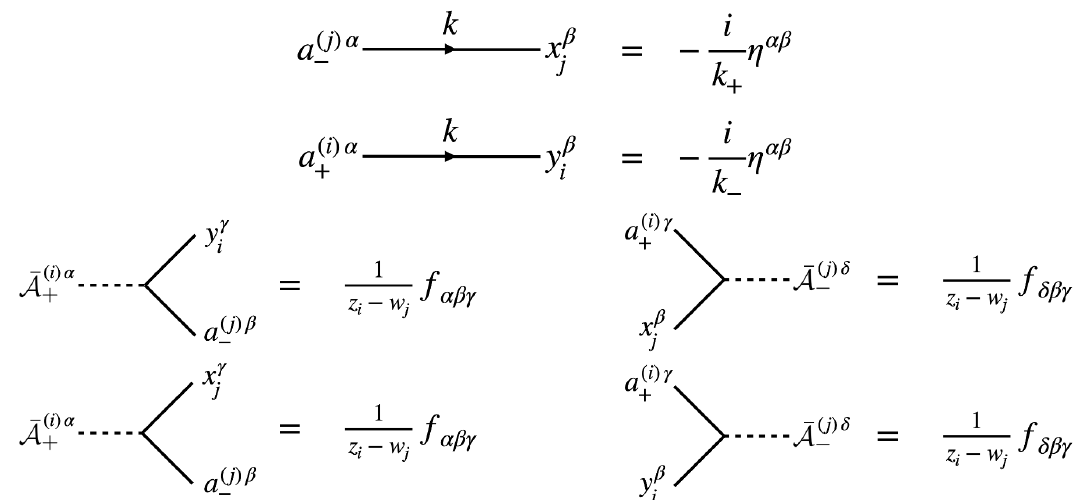
Figure 5 . The Feynman rules following from the path integral (4.4). The indices i and j respectively run over the sets P + and P − in (4.1). We denote ¯ A ( j )